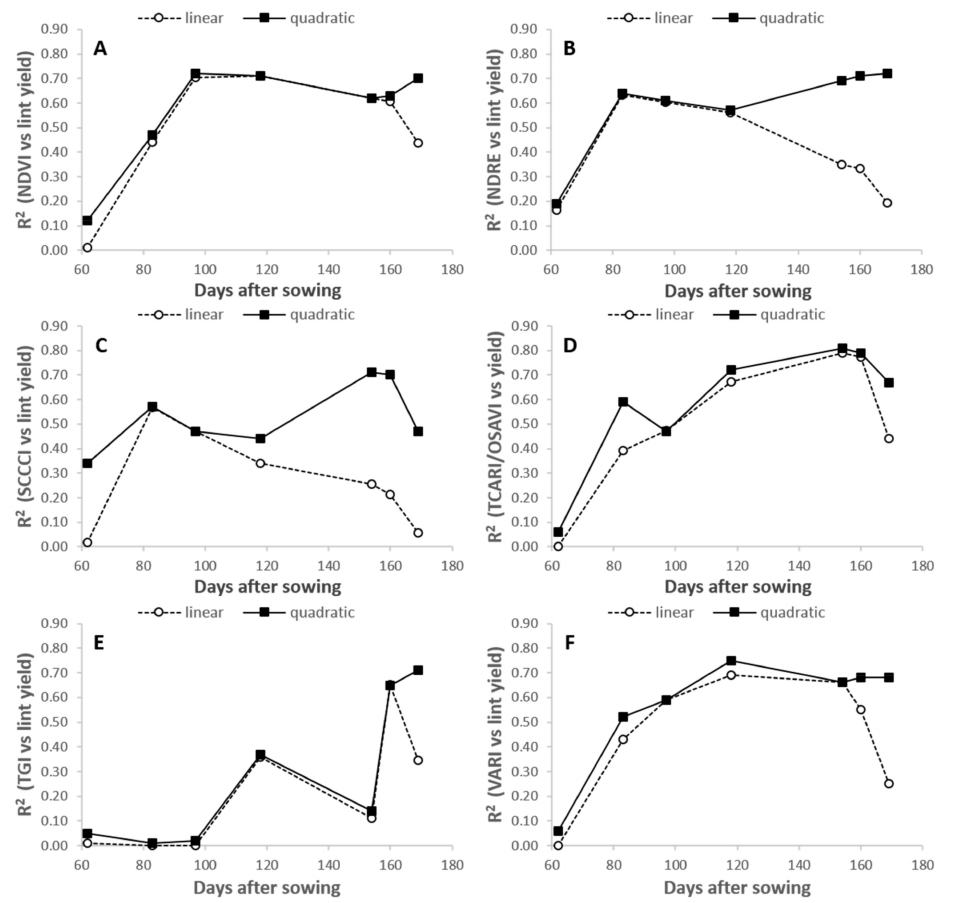
Figure 6. Time series for the coefficient of determination obtained from the relationships between lint yield and the normalized difference vegetation index (NDVI; A ), normalized difference red edge index, NDRE ( B ), simplified canopy chlorophyll content index (SCCCI; C ), transformed chlorophyll absorption reflectance index normalized by the optimized soil adjusted vegetation index (TCARI/OSAVI; D ), triangular greenness index (TGI; E ) and visible atmospherically resistant index (VARI; F ) using a linear and quadratic regression